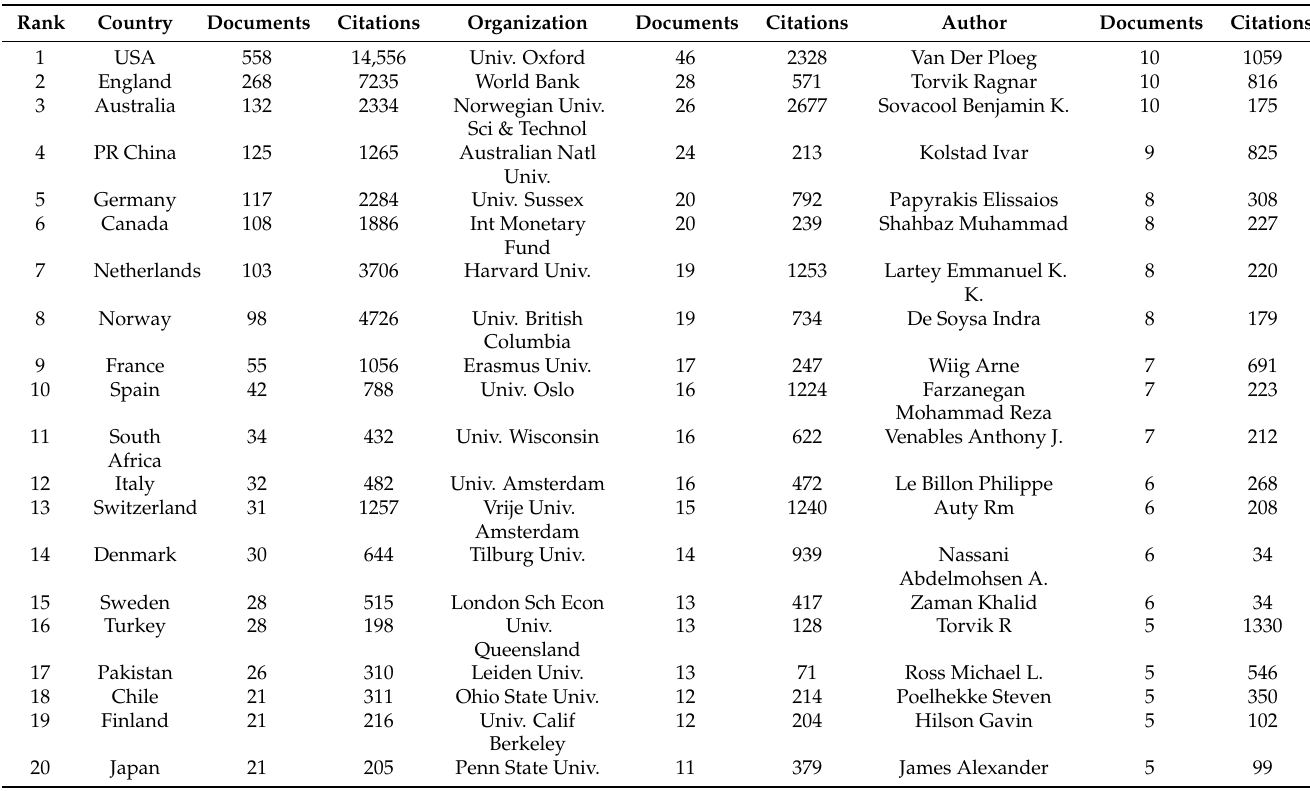
Figure 8. Institutes co–authorship network. Table 3. Publication number by countries, institutions, and